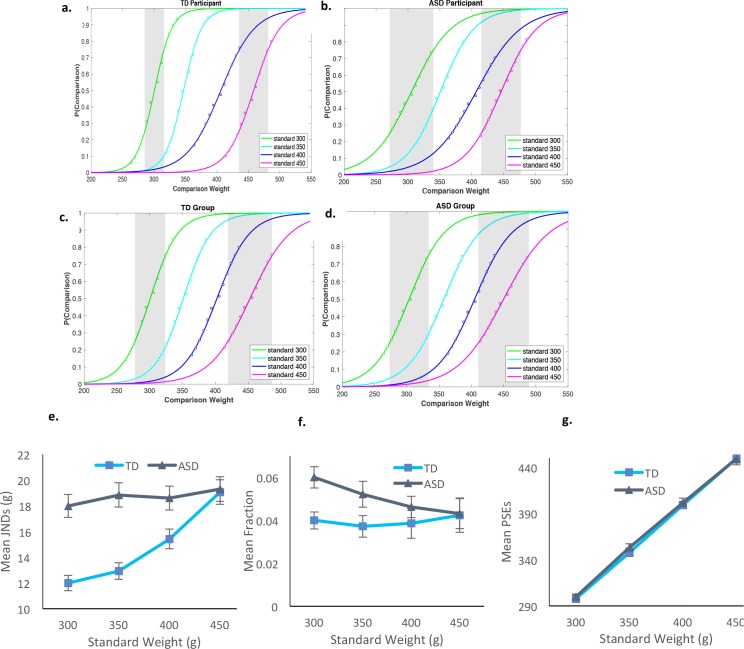
Results for Exp. 2.Psychometric functions, plotting the proportion of trials in which participants reported the comparison as heavier, as a function of weight of the comparisons. The different functions refer to the four standards. (a) Data for a representative TD participant. (b) Data for a representative individual diagnosed with ASD. (c) All data for the typical group pooled (n = 11). (d) All data for the ASD group pooled (n = 12). The shaded gray areas in each graph signify JNDs for standards of 300 and 450 g. (e) JNDs increased linearly with weight only for the TD group. (f) Weber’s fractions were computed as the ratio of the JNDs to the PSEs (JNDs/PSEs), computed for each weight for each participant. These fractions did not remain constant as a function of weight for ASD, violating Weber. (g) PSEs demonstrated accurate perception in both groups. As in the visual estimation task, TD adults showed a subtle tendency to underestimate the standard weights. Error bars in e-f indicate standard errors.